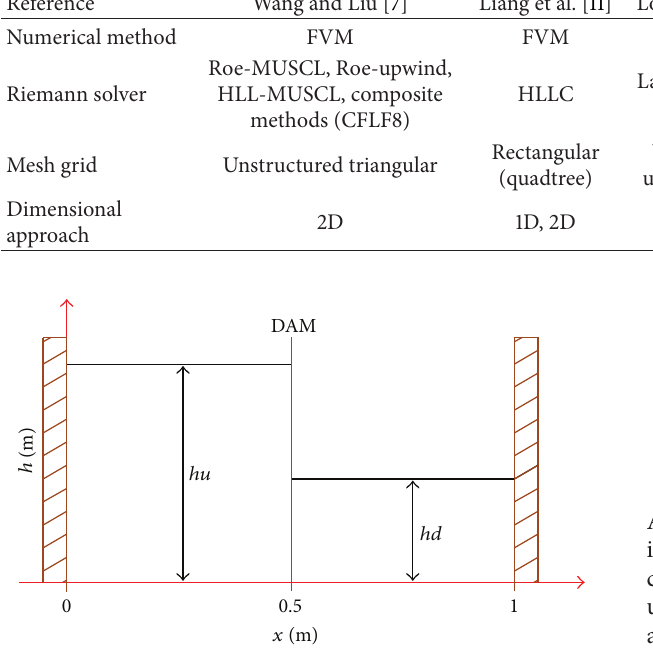
Figure 3: 1D Studied domain for